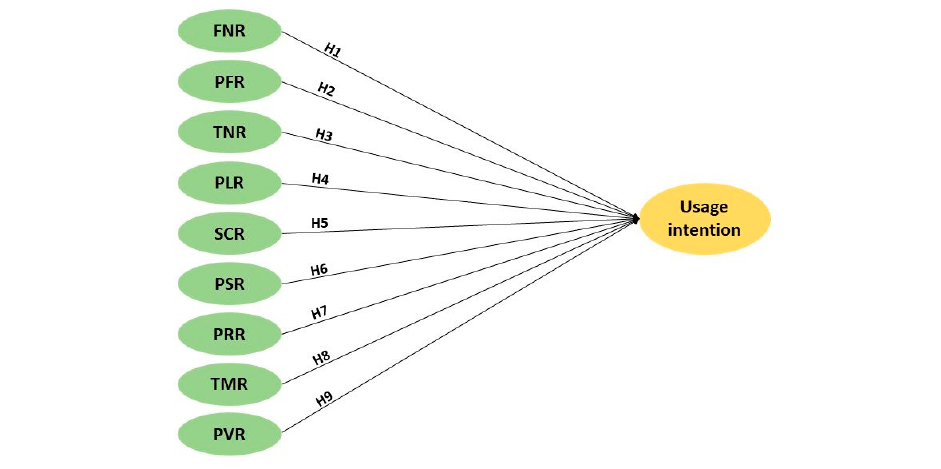
Figure 1. Research model and